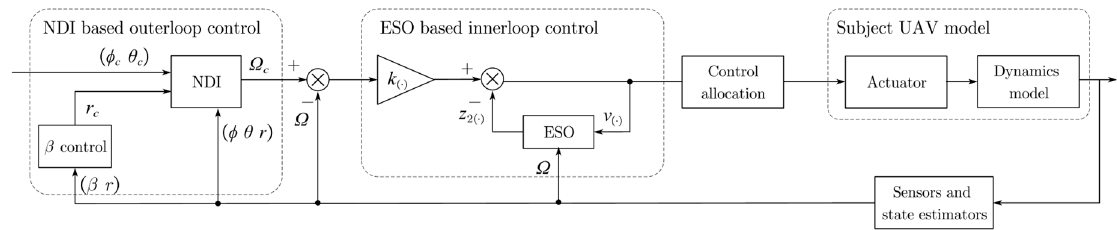
Figure 14. Complete control diagram for inner and outer loop control.